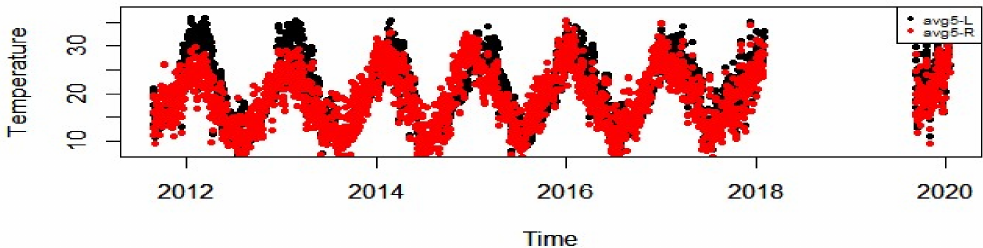
Figure 10. Avg5-R against avg5-L (Temperature in ◦ C).